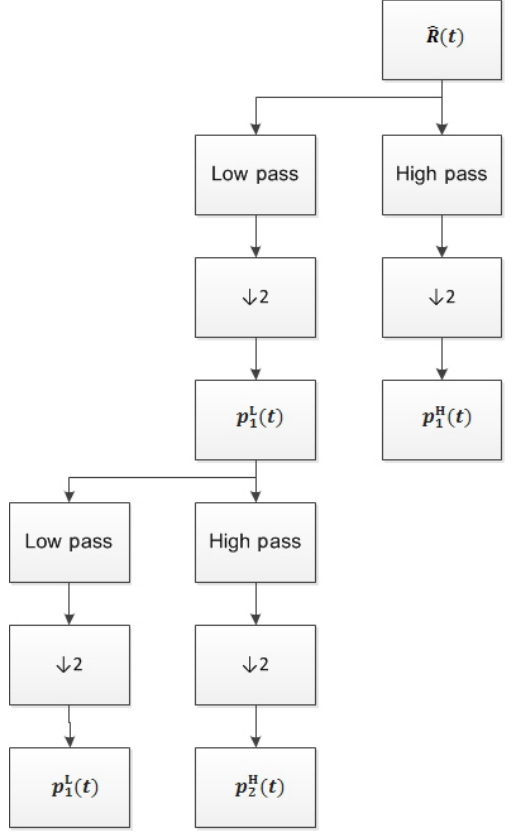
Figure 1. A schematic showing the pyramid algorithm used to de- compose and downsample ( ↓ 2 ) an input signal ( b R ) into high- and low-frequency components. The input signal is filtered using the high- and low-pass filters described in Eqs. (7) and (8) before being downsampled to produce the level 1 high- and low-pass parame- ters. The low pass parameters are now used as input for the high- and low-pass filters. This process of filtering and downsampling is repeated until the desired level of decomposition is